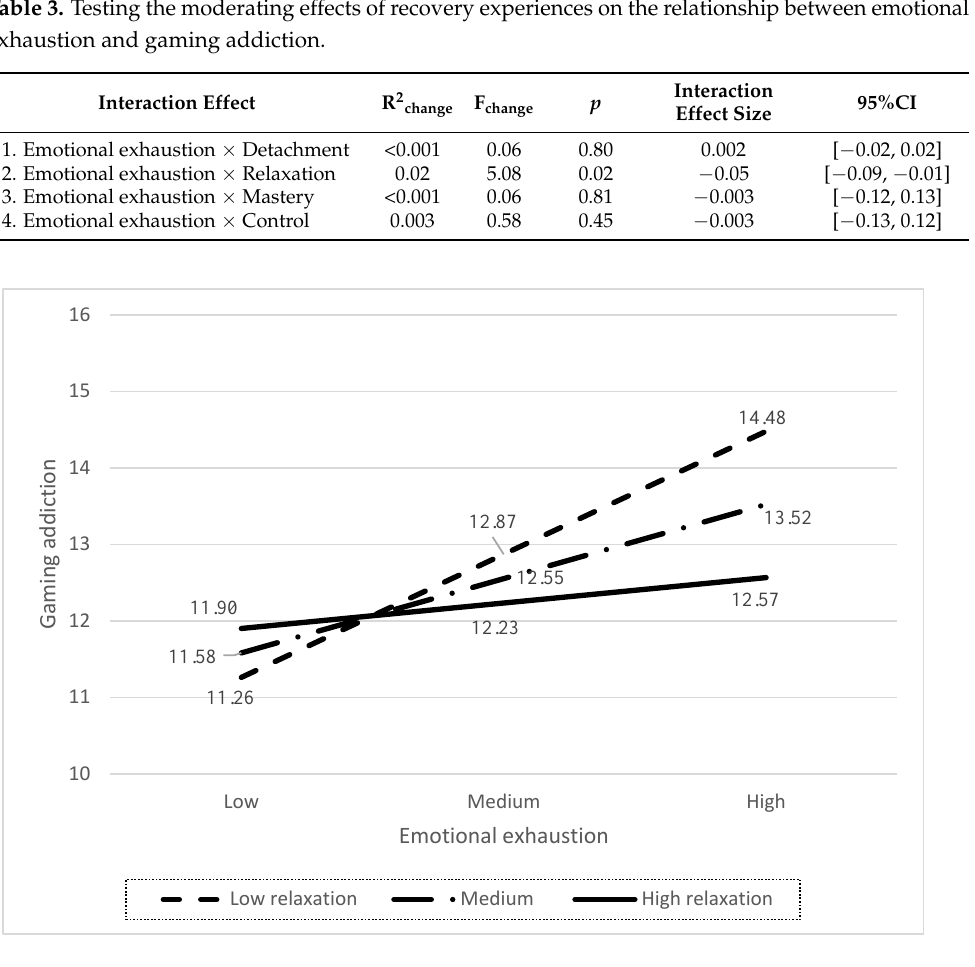
Figure 2. The illustration of the buffering effect of relaxation experience. Note: Means of three groups in relaxation are 14.81, 17.22, and 19.63, respectively.